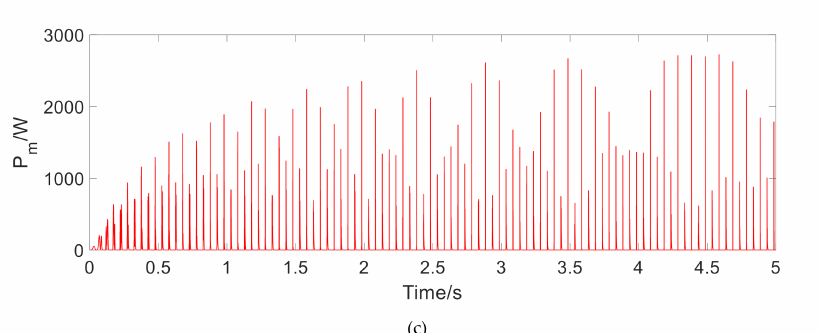
Figure 7. The instantaneous output power of regenerative motor under sinusoidal excitation. ( a ) Output power at 1.5 Hz, ( b ) Output power at 6 Hz, ( c ) Output power at 10 Hz.